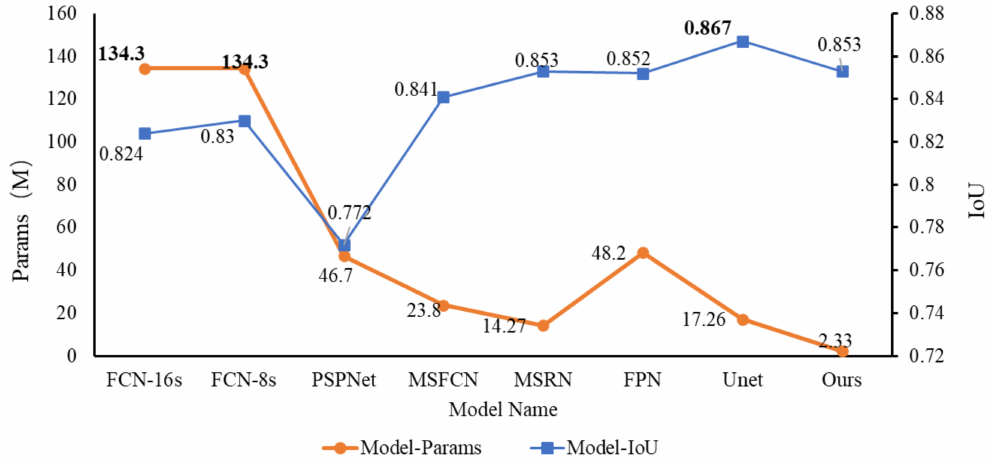
Figure 11. Comparison of IoU and parameter scale of different